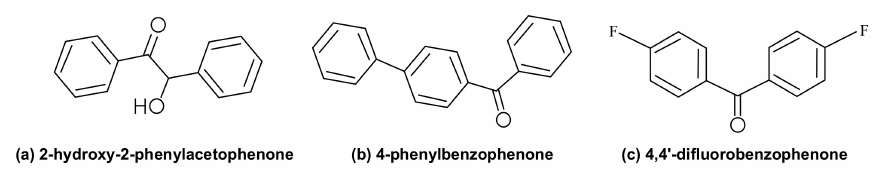
Figure 1. Molecular structures of polycyclic